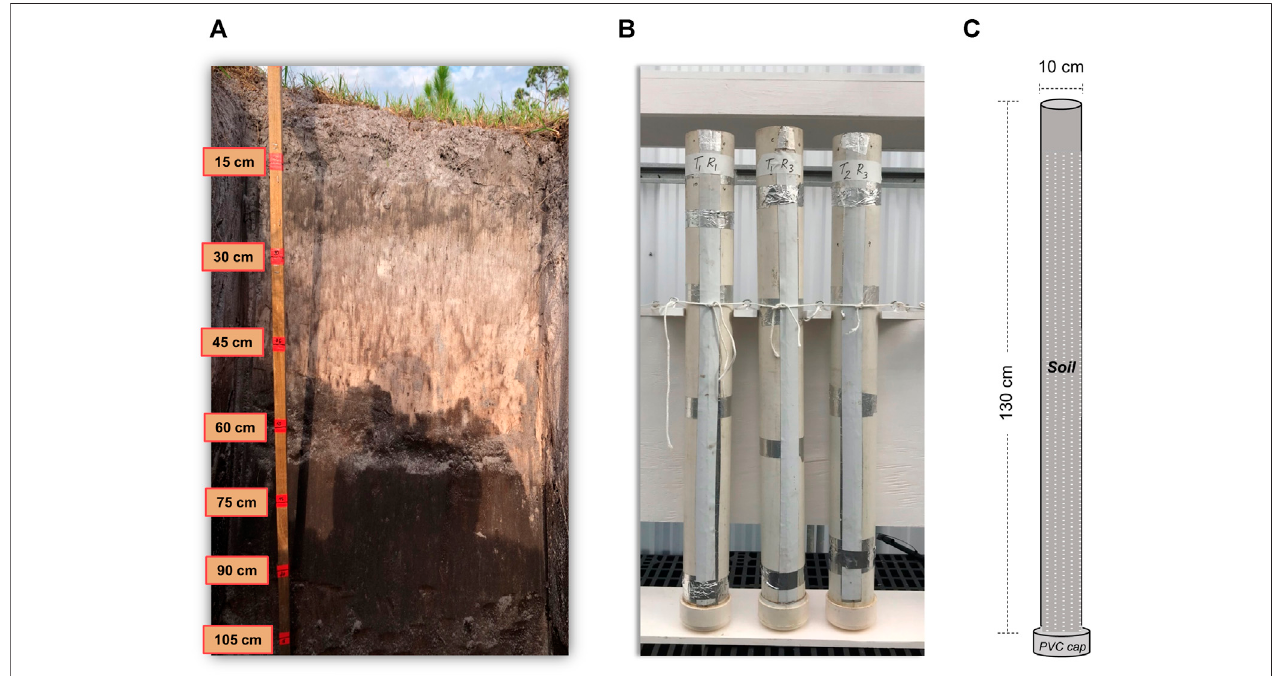
FIGURE1|(A) Pictureofsoilpro fi leusedforpackingthecolumns (B) Pictureofsoilleachingcolumnsusedintheexperiment (C) Diagramofasoilleachingcolumn.